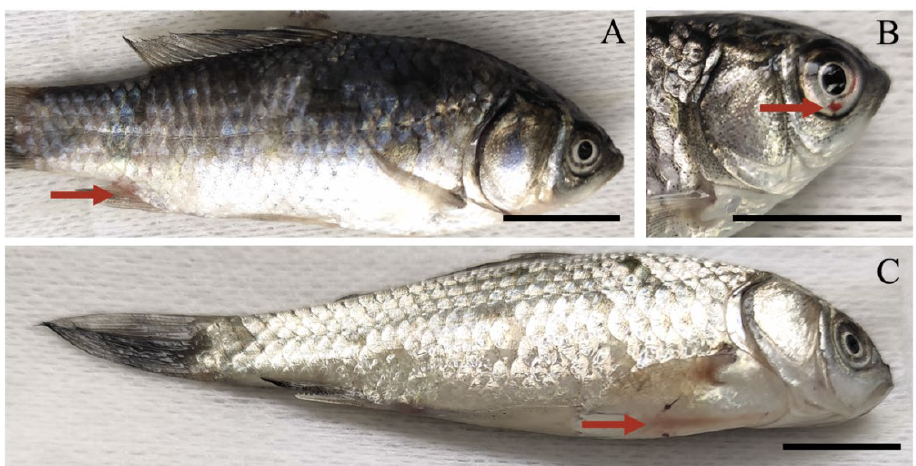
Figure 7. The external surface of CaHV-infected crucian carp. ( A – C ) Suspected hemorrhage appeared on fish, the red arrows indicate the suspected hemorrhage. The blue arrow indicates the swelling and inflammation at the blood collection site. Scale bar = 1 cm.